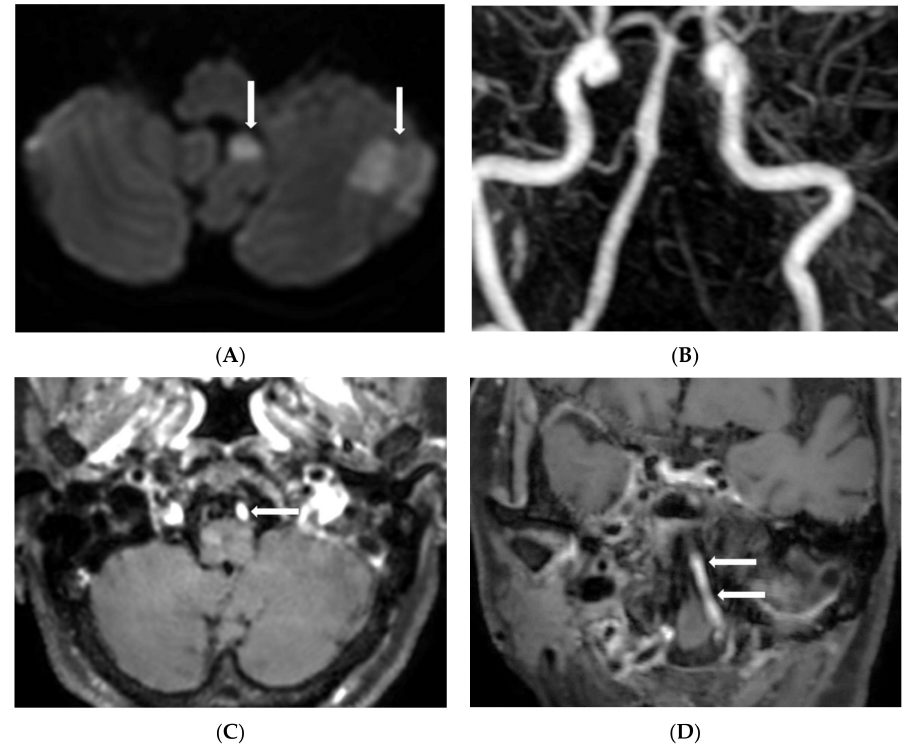
Figure 2. An 83-year-old woman with acute vertigo attack. ( A ) Diffusion-weighted imaging shows the acute infarction in the left posterior inferior cerebellar artery territory (arrows); ( B ) Contrast-enhanced MRA shows no visualization of the left vertebral artery; ( C ) Axial imaging of black-blood enhanced MR imaging shows strong enhancement of left vertebral artery (arrow); ( D ) Coronal reformatted imaging of black-blood-enhanced MR imaging shows long segment contrast enhancement of left vertebral artery (arrows). This finding suggests contrast stagnation by acute occlusion of the distal vertebral artery related to acute infarction of the posterior inferior cerebellar artery